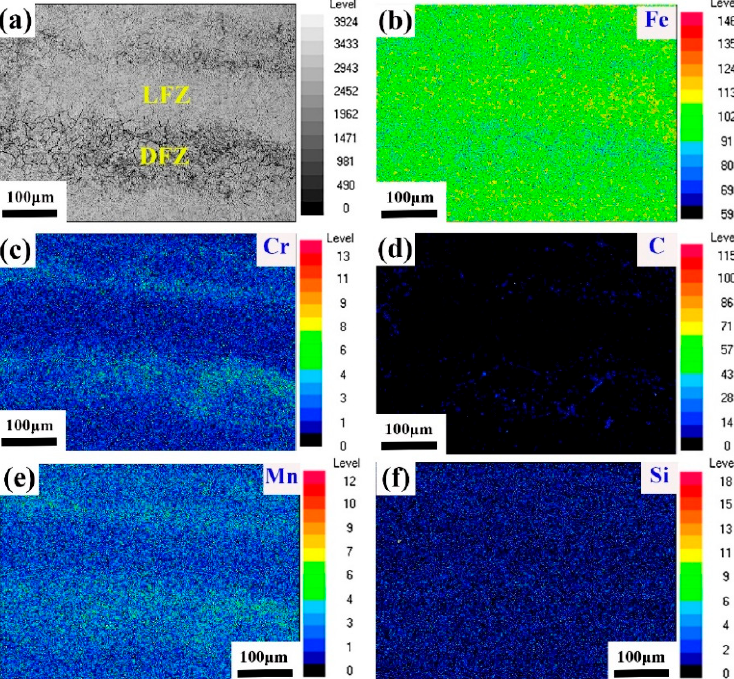
Figure 3. EPMA mapping the flow lines in hot-rolled bearing steel: ( a ) secondary electron image of the flow lines; ( b – f ) distribution of the main elements.